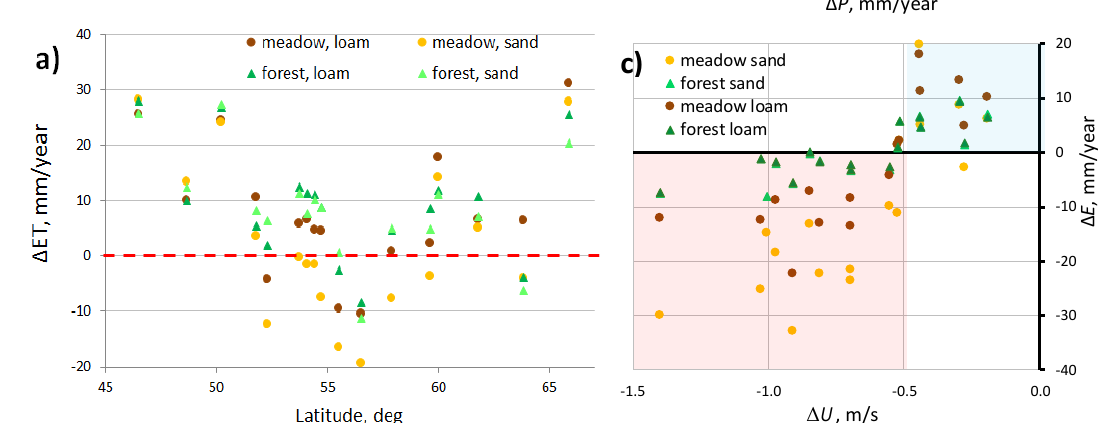
Figure 10. Modeled latitudinal modern changes in mean annual evapotranspiration ∆ ET ( a ) and correlations: between changes in mean annual transpiration ∆ TR and precipitation ∆ P ( b ); between changes in average annual evaporation ∆ E and wind speed Δ U ( с ) .